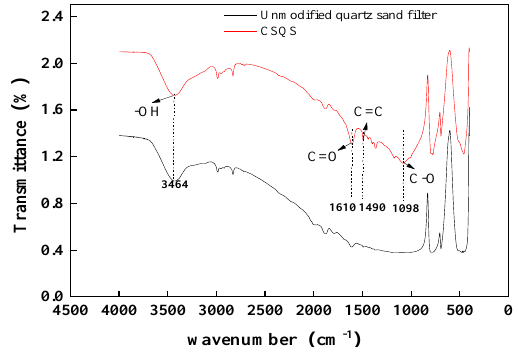
Figure 6. FTIR spectra of CSQS.